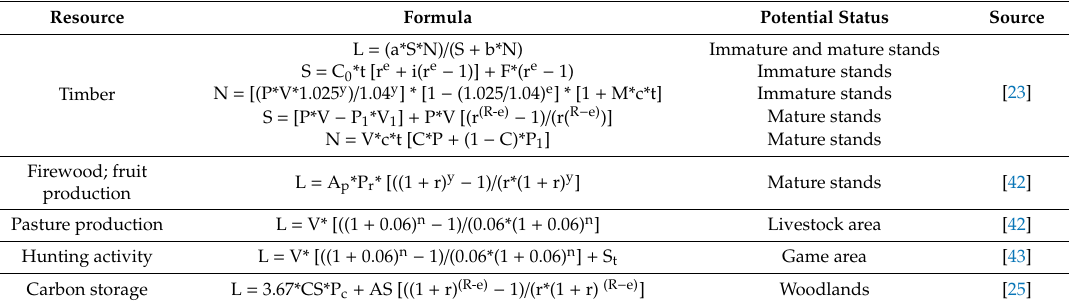
Table 3. Formulations used for economic